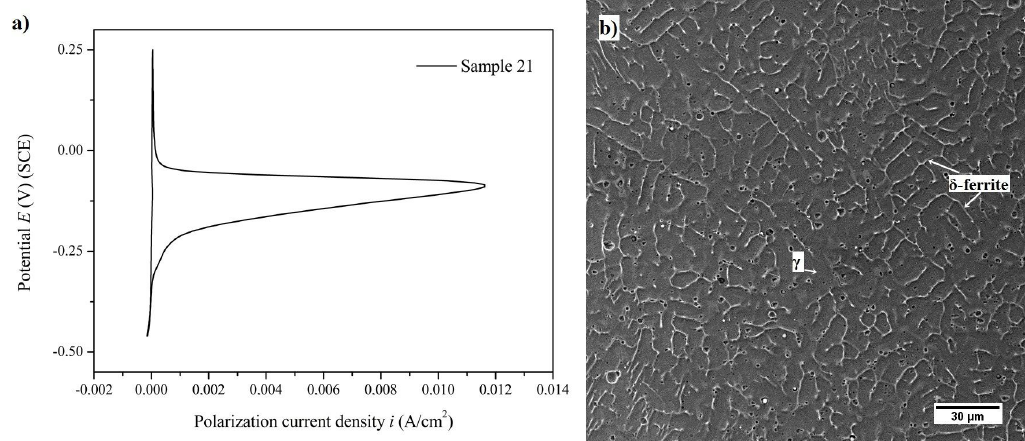
Figure 2. Characterization of sample 21: (a) DLEPR polarization curve and (b) microstructure of cladding (SEM Table 4. Dilution results and chemical composition of the weld metal (wt. %) estimated by Schaeffler diagram. Weld metal Dìlution